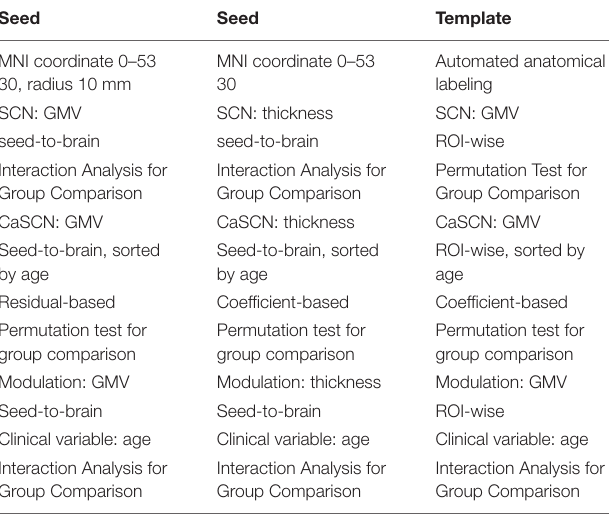
Interaction Analysis for Group Comparison BCCT, brain covariance connectivity toolkit; CaSCN, causal analysis of structural covariance network; GMV, gray matter volume; ROI, region of interest; SCN, structural covariance